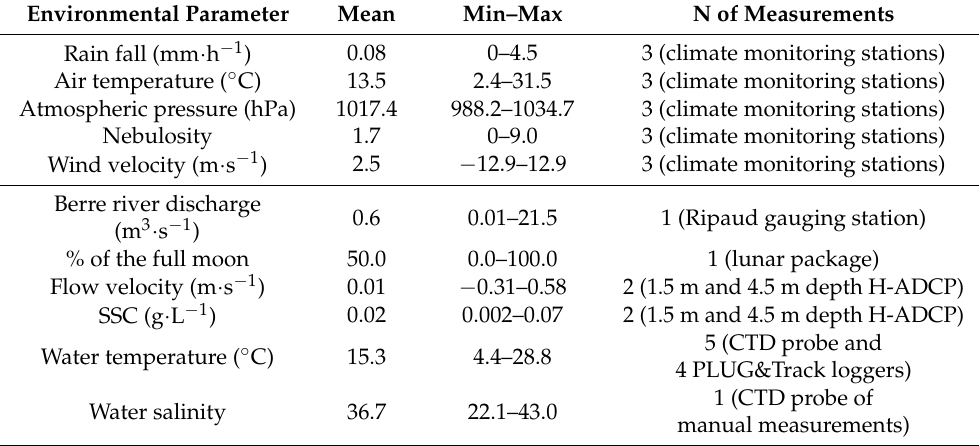
Table 1. Summary of environmental parameters obtained or measured during the study (Oct 2018– April 2020). The number of instruments used to measure the parameters and the type of instruments are specified. When more than one instrument measured the same parameter, the mean values measured by the different instruments were kept in the